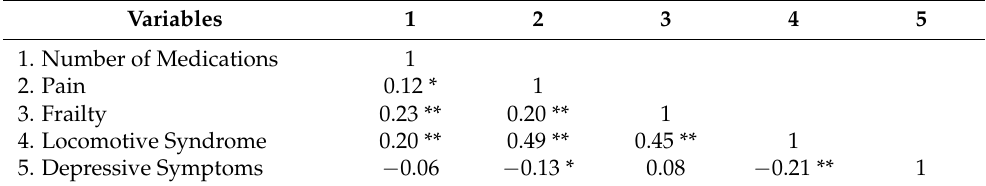
Table 3. Correlation matrix for study variables ( n =